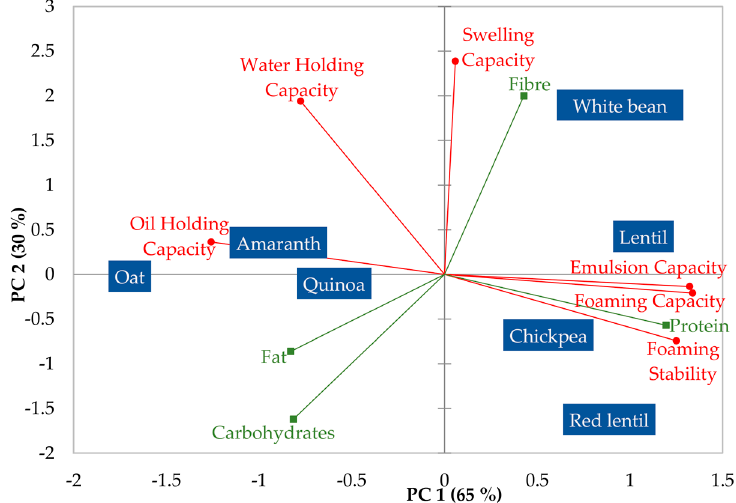
Figure 1. PCA plot showing variation in fl ours from di ff erent vegetable sources according to their techno-functional properties. The proximate composition variables were included as supplementary variables.